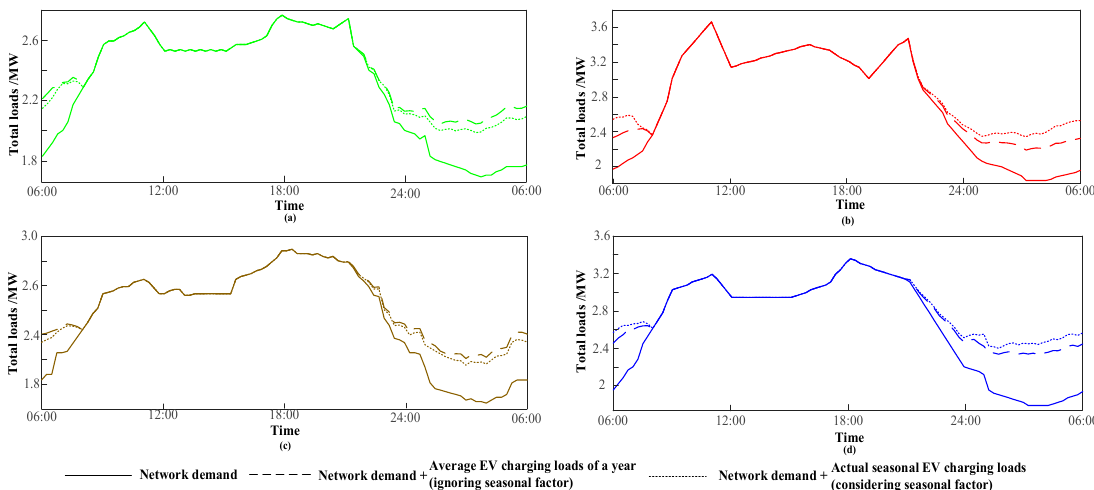
Figure 10. Optimized daily load curves of the given network by applying the proposed charging